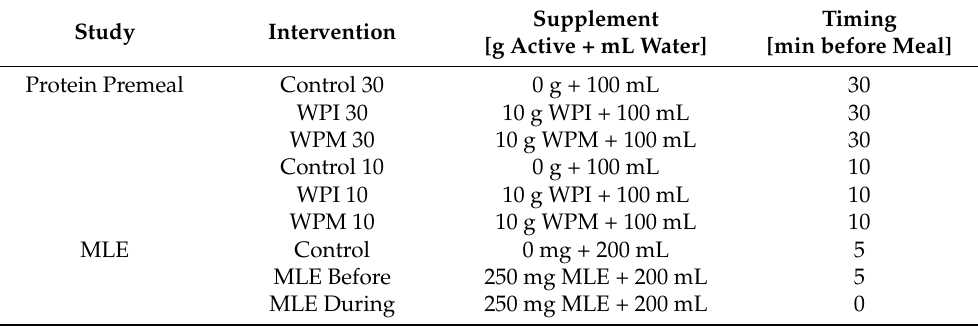
Supplement Timing [g Active + mL Water] [min before Meal]